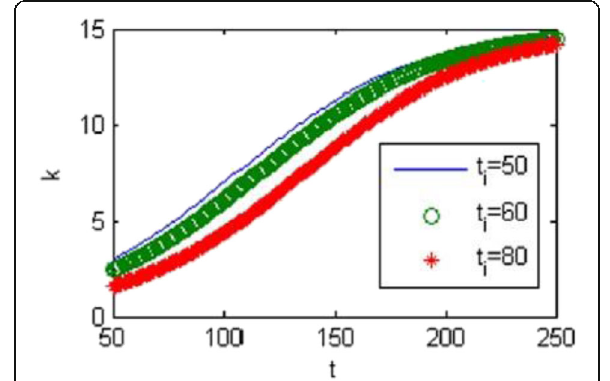
Fig. 7 Degree of network with different t i by modified model Fig. 5 The degree distribution with uniform energy